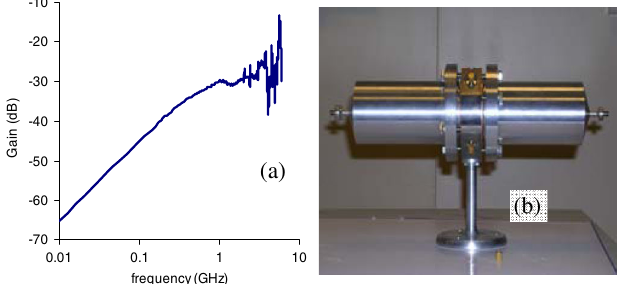
FIG. 3. (Color) (a) The measured transfer function of an IPHI BPM button. The gain is the ratio of the button voltage to the voltage injected into the 50 (cid:1) adapted pipe. (b) The cutoff frequency 707 MHz corresponds to the time constant 4 : 5 pF (cid:4) 50 (cid:1) . The ripples around 4 GHz are due to the bad mechanical adaptation between the tube and the BPM block. The character- istic impedance along the line is not suitable for high frequen- cies. Nevertheless, we do not see a frequency limitation up to 6 GHz and never have reached the high cutoff frequency of the BPM itself.